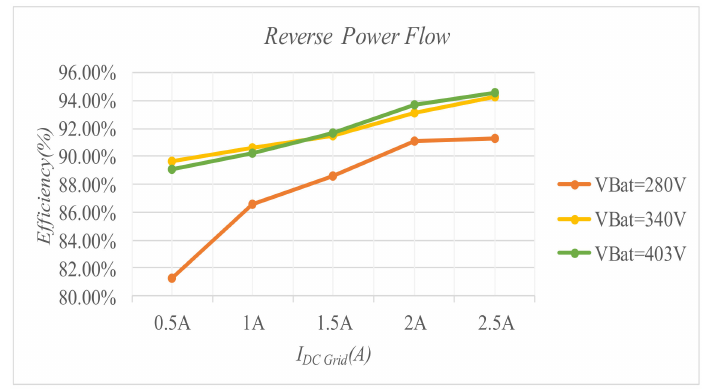
Figure 21. Conversion e ffi ciency curves for the reverse discharging